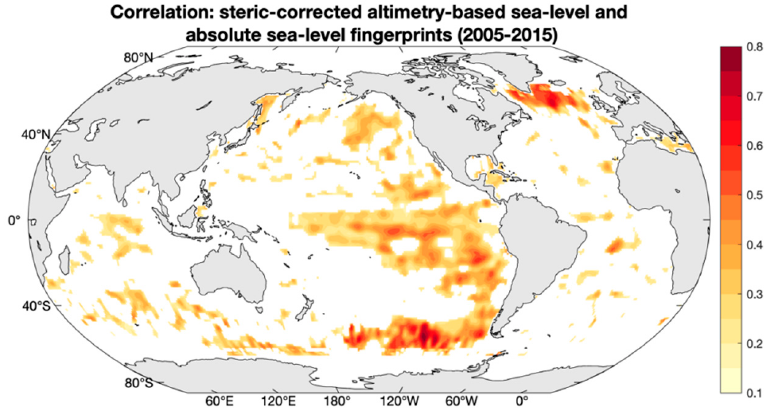
Figure 4. Uncertainty at 90% confidence level (i.e., 1.65 σ ) map for the ensemble mean (NOAA, EN4, SIO and JAMTEC) steric sea-level trend for the time interval January 2005–December 2015, based on the maximum differences between the different data sets.